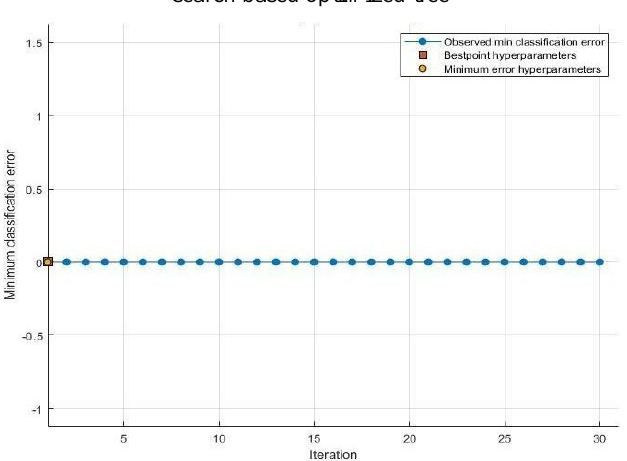
Fig. 28. Video injection minimum classification error of grid search based optimized tree